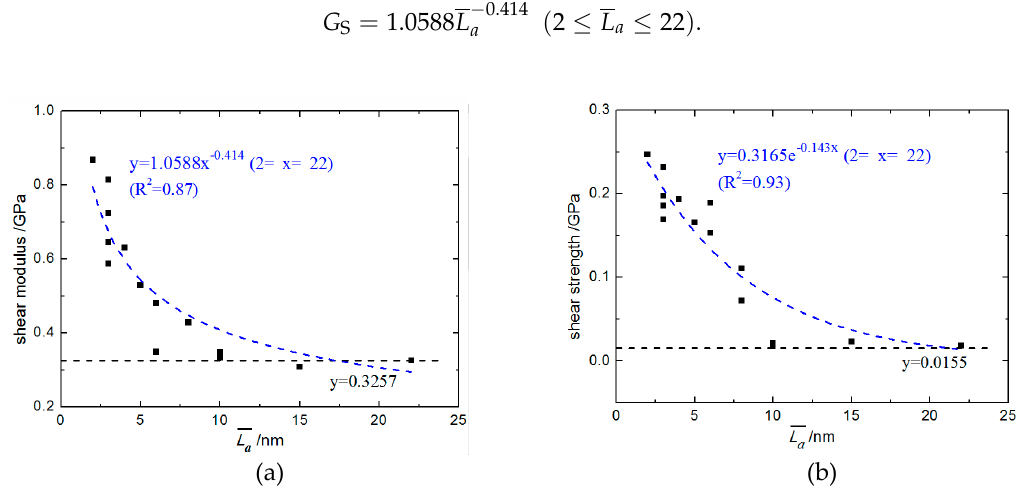
Figure 11. The tangential shear mechanical properties of the C f /PyC interphase with different sizes of L a : ( a ) Modulus; ( b ) Strength.